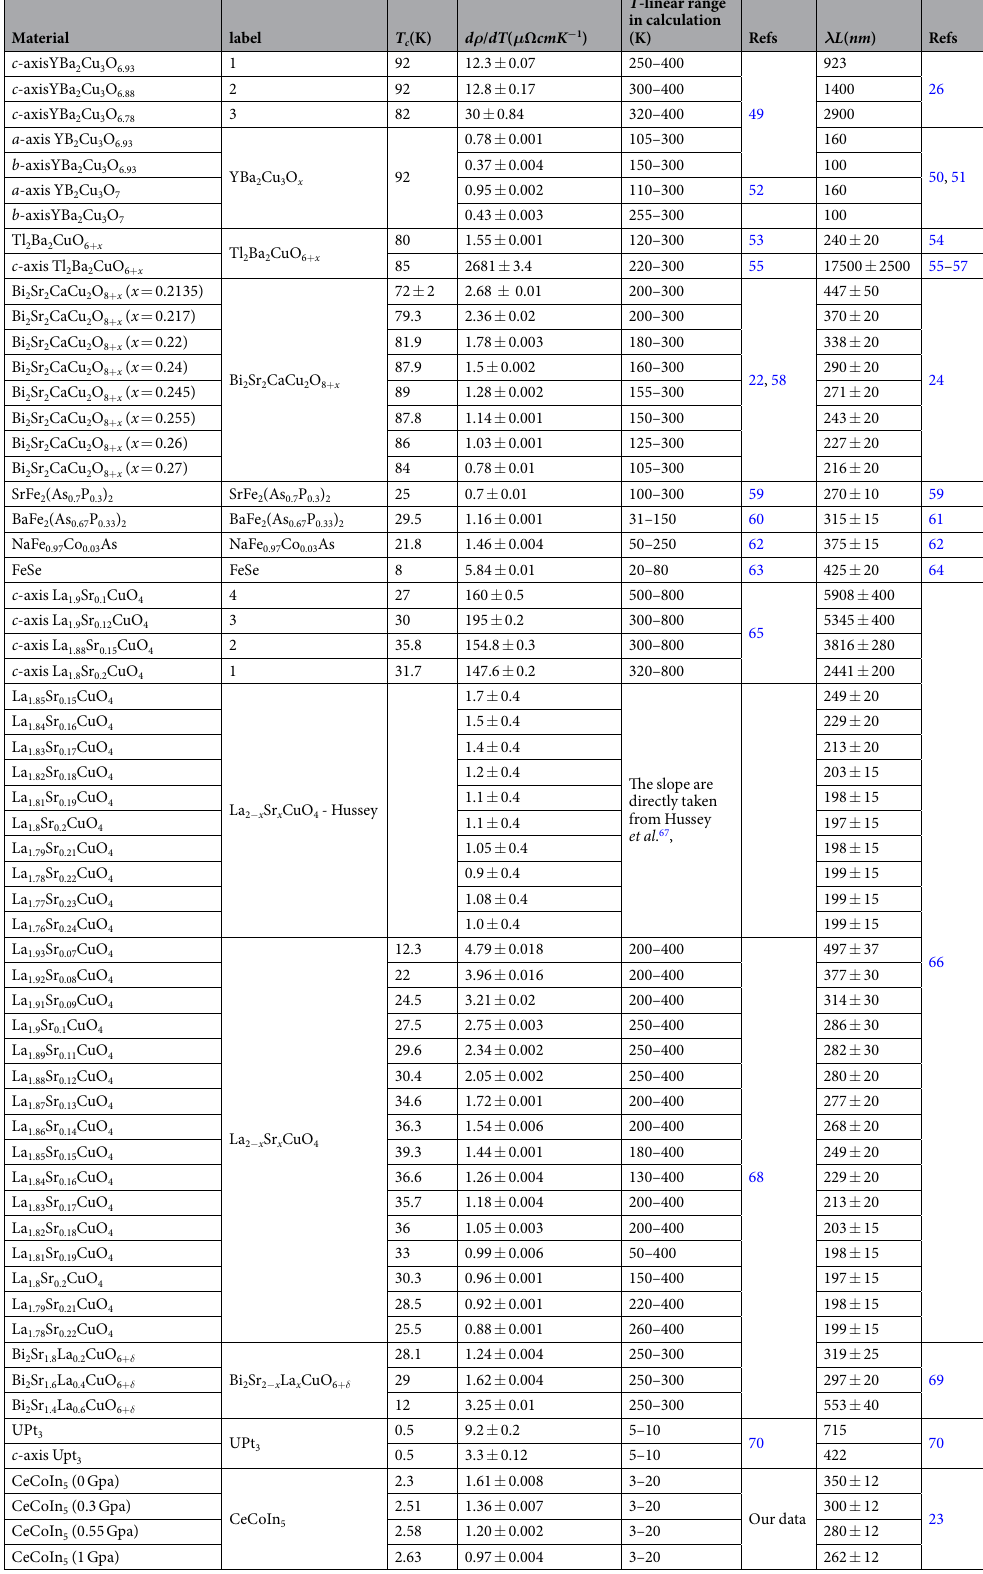
Table 1. Transport parameters and London penetration depth at zero